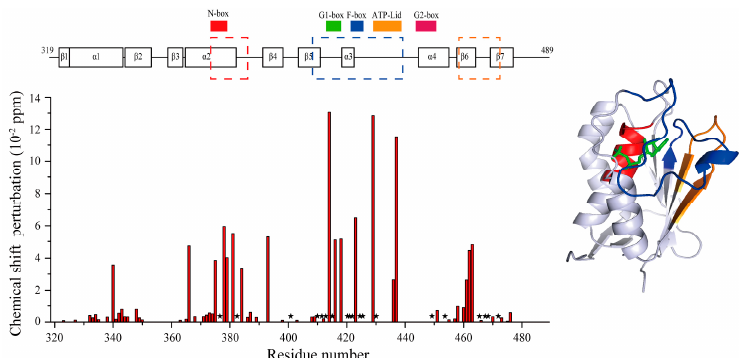
Figure 5. Chemical shift perturbation of residues after Lut binding. Disappeared signals are represented by ★ . Obviously changed regions are respectively colored by red, blue and orange.